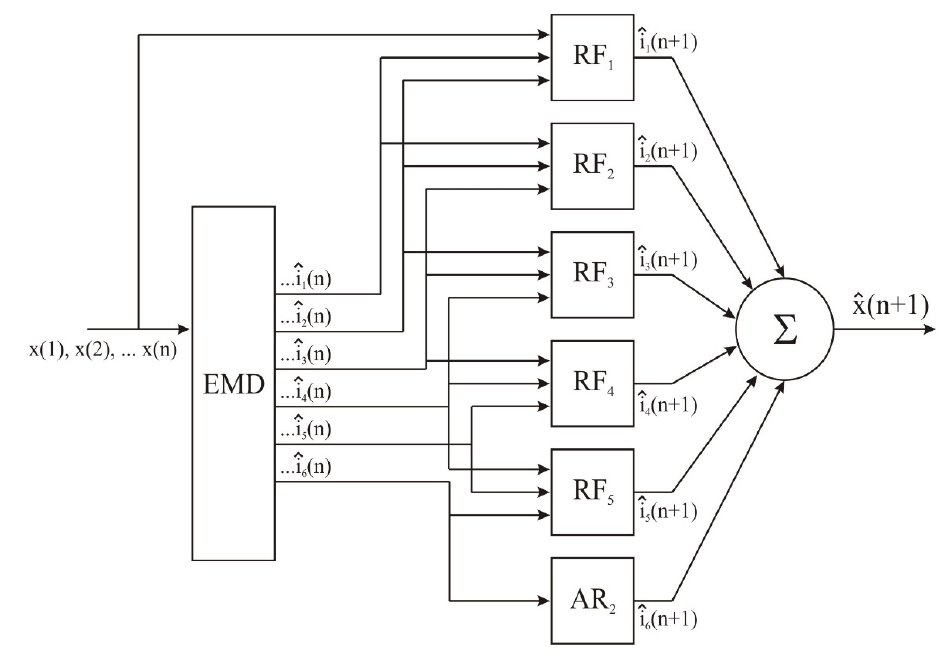
Figure 2. RF–IMF Figure 2. RF–IMF model.